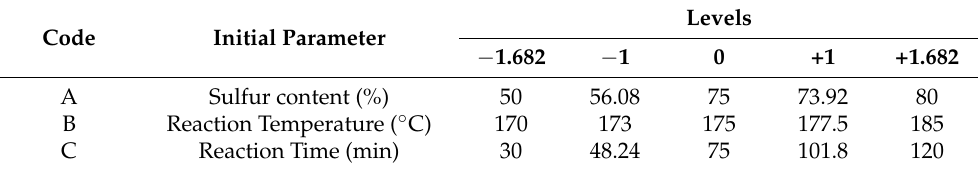
Table 1. Chosen variable with their coded